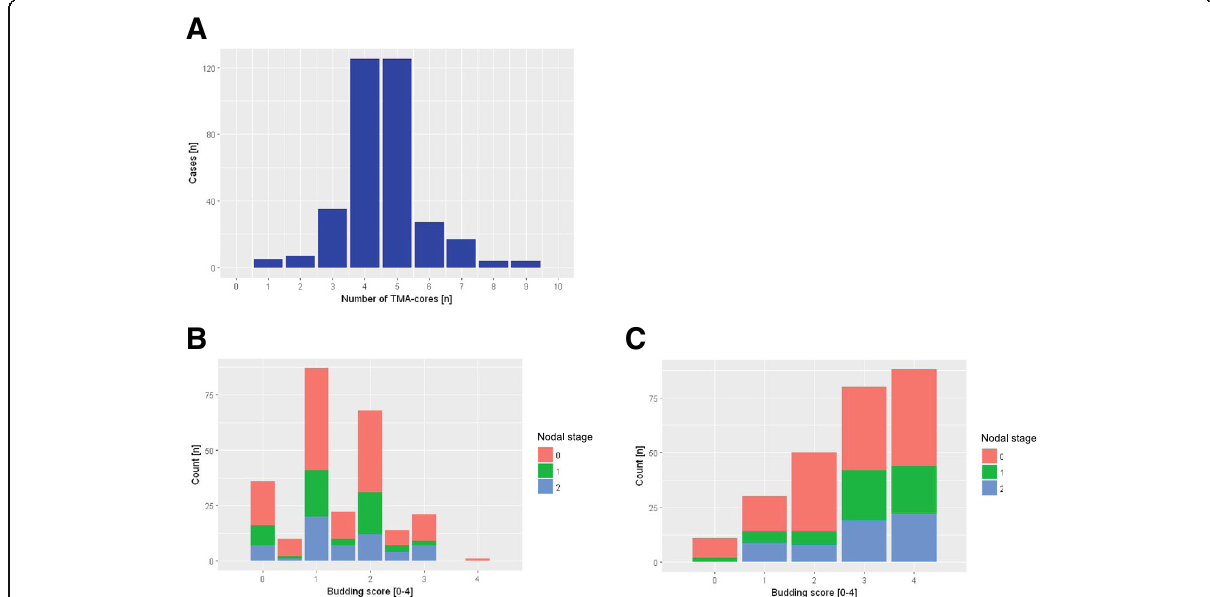
Fig. 6 Correlation of the TMA data to clinical data. a Histogram of the number of TMA cores from the tumor region per case ( n = 4 ± 2). b , c Histogram of the b median budding score per case [0 – 4] and the c maximal budding score per case. The nodal status [pN0 – 2] is added by color